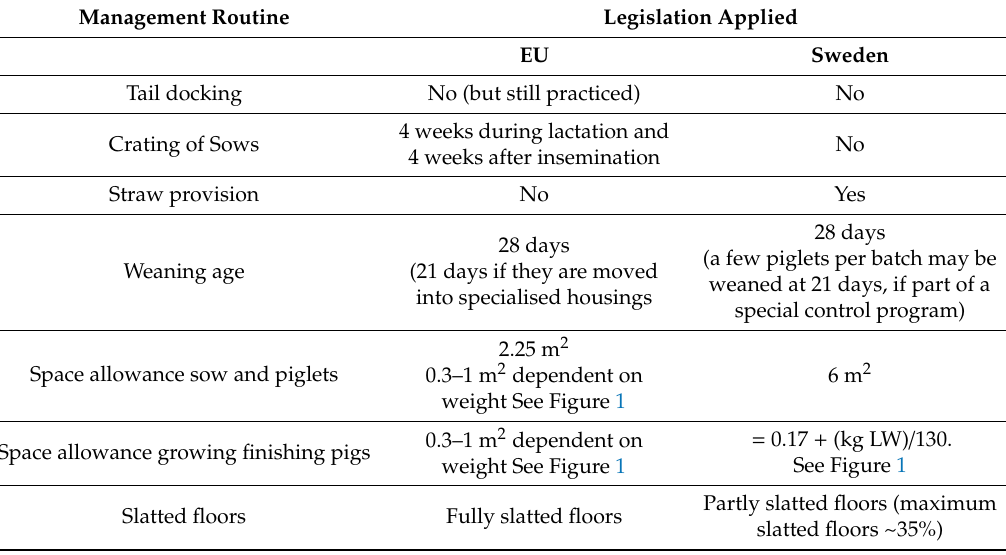
Table 1. Management routine in pig production in EU member states solely complying with the Council Directive 2008 / 120 / EC [13] and Sweden